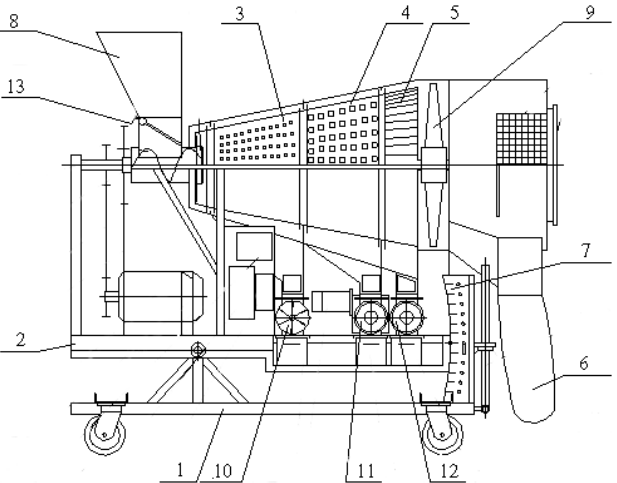
Figure 1. View of the stationary rotary cleaning device: 1–stationary frame, 2–mobile frame, 3–fine impurity segment, 4–fine grain segment, 5–plump grain segment, 6–chaff outlet container (bag), 7–indicator of sieve drum inclination angle, 8–hopper, 9–blower, 10–rotary valve of fine impurity segment, 11–rotary valve of fine grain, 12–rotary valve of plump grain segment, 13–valve closing mixture outlet.